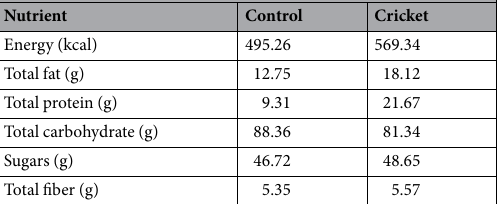
Table 1. Estimated Nutrient Composition of Study Breakfasts.